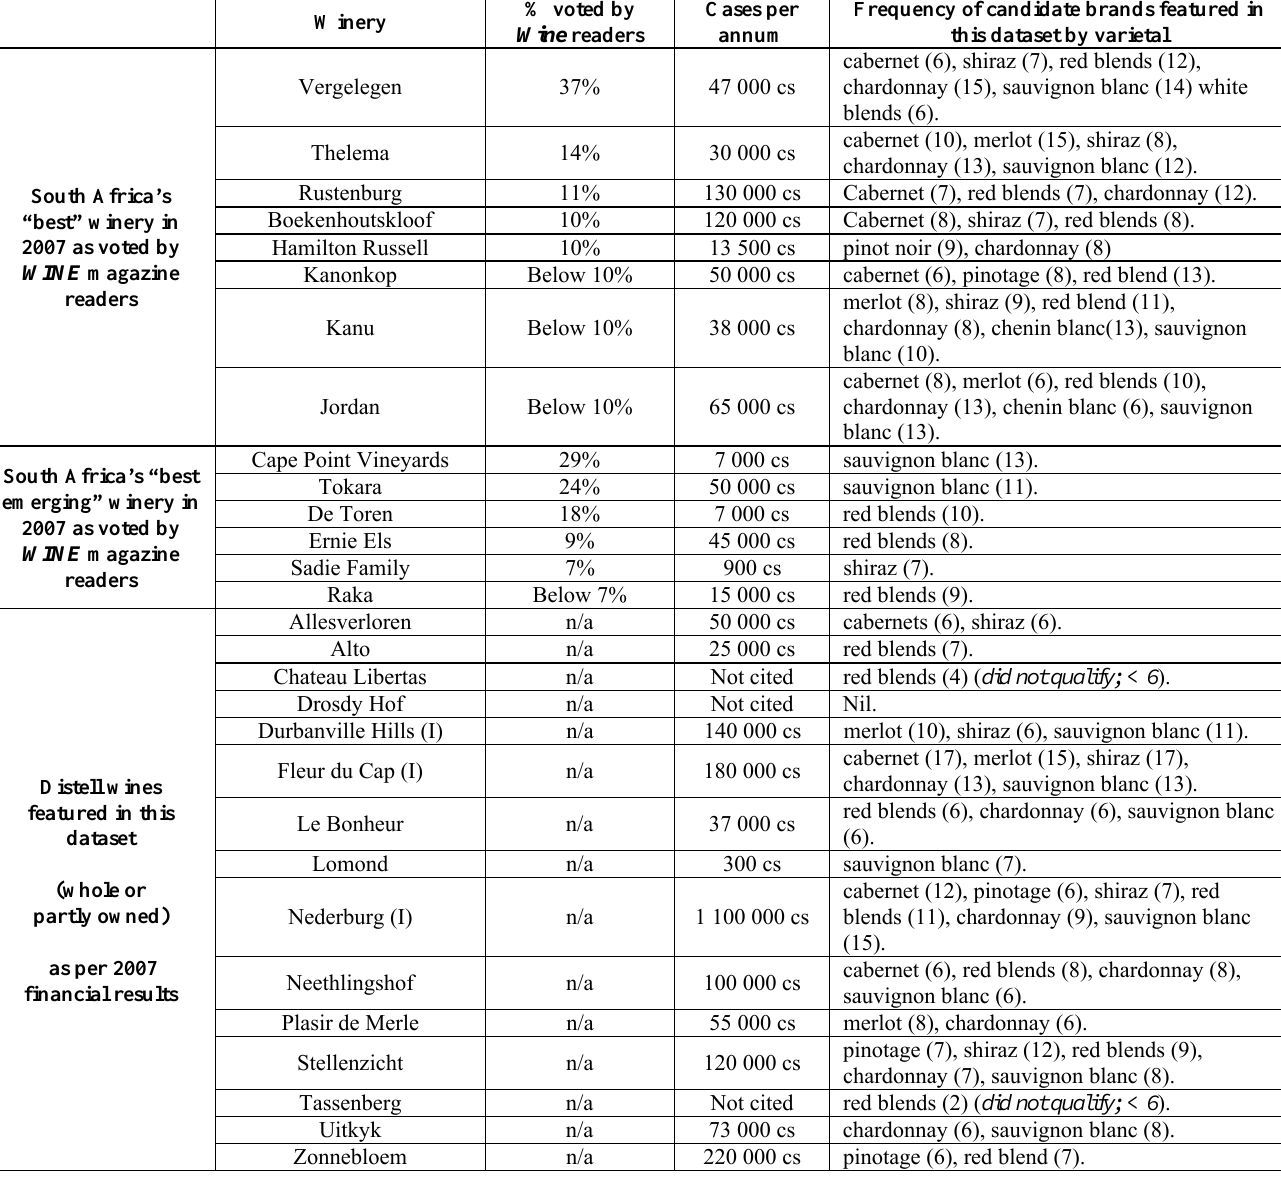
Table 1: Prominent South African wineries as per (1) a June 2007 WINE magazine survey and (2) Distell’s listed wine brands – their annual case output and their relative significance within the dataset. (sources: Boom, 2006; Van Zyl, 2007; Wine, 2007; and the 2007 financials of the JSE listed Distell liquor group.) Distell wines with an (I) denote an international